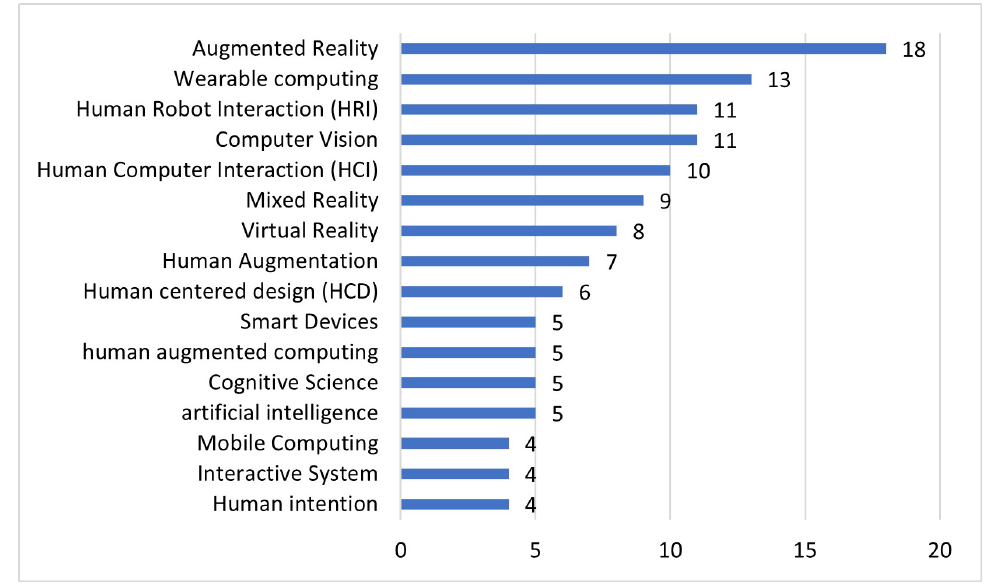
Figure 7. Top Keywords with